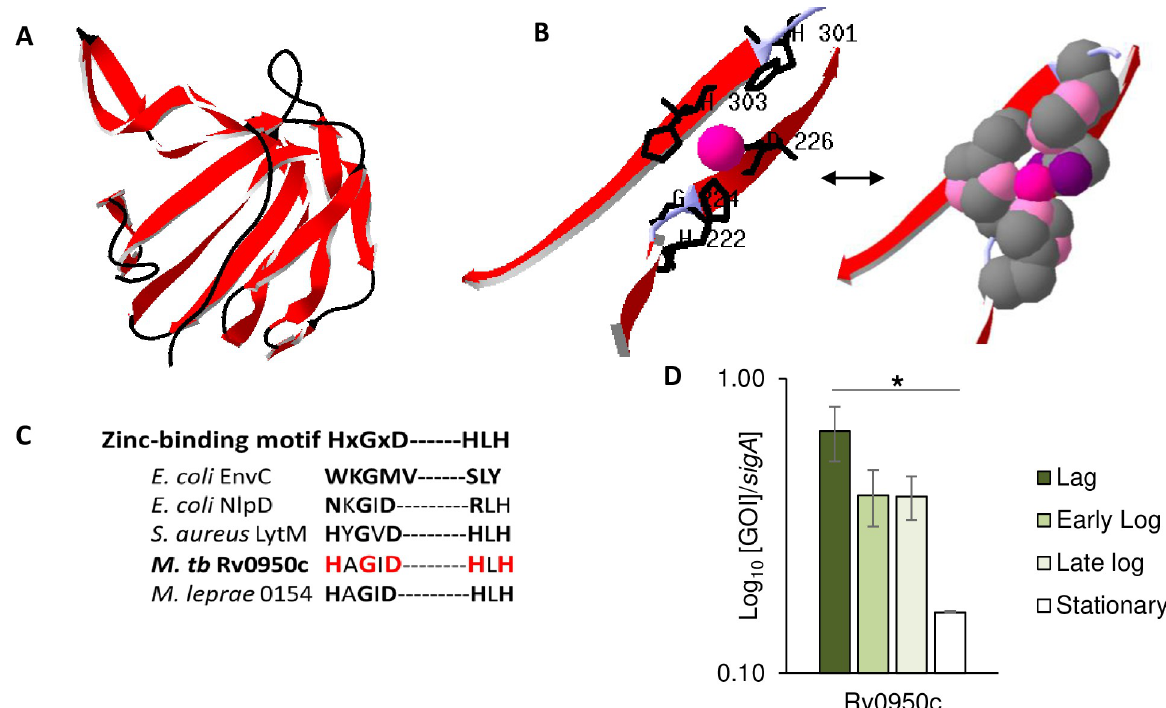
Fig 2. Homology modelling and transcriptomics suggest that M . tuberculosis Rv0950c is an active M23 endopeptidase expressed during growth. A) Rv0950c modelled with homology to N . gonorrhoeae Mpg (6muk); Red: β -sheets. B) The putative zinc-binding site of Rv0950c modelled to V . cholerae ShyA (6u2a.1). Zinc indicated in Magenta; Zinc-binding residues indicated in black. Space fill model predicts co- ordination of the Zn by nitrogen atoms (light pink) of H222, H303 and Oxygens (purple) of D226. C) Amino-acid sequence alignment of the M23 endopeptidase showing the conserved zinc-binding motif in the M23 endopeptidase domain of Rv0950c and the degenerate nature of this motif in E . coli homologues. D) Growth-phase dependent transcription of Rv0950c. Expression levels were measured by qPCR in three independent cultures and normalised to sigA. � p < 0.02 by single-factor for Rv0950c ANOVA in Excel.